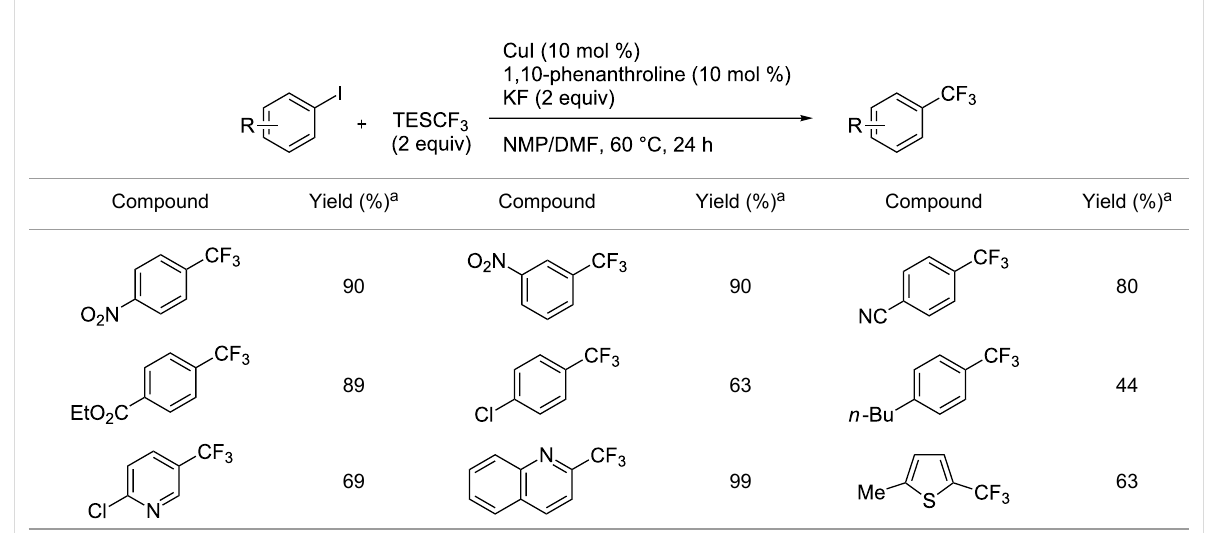
methylating agent, the silver salt also acts as a stabilizer for the CF 3 − species and prevents its self-decomposition (Figure 4). As a result, the more economical TMSCF 3 can be employed, and good yields were observed for both electron-rich and electron- poor aryl iodides in this cooperative silver-assisted copper- catalyzed trifluoromethylation (Table